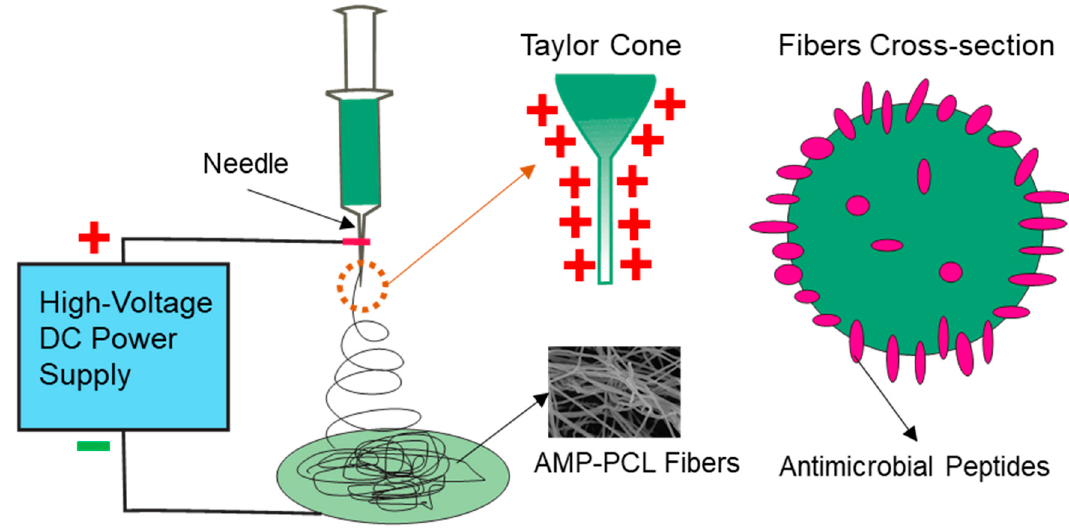
Figure 7. Schematic illustration of antimicrobial peptides distribution during the electrospinning process.